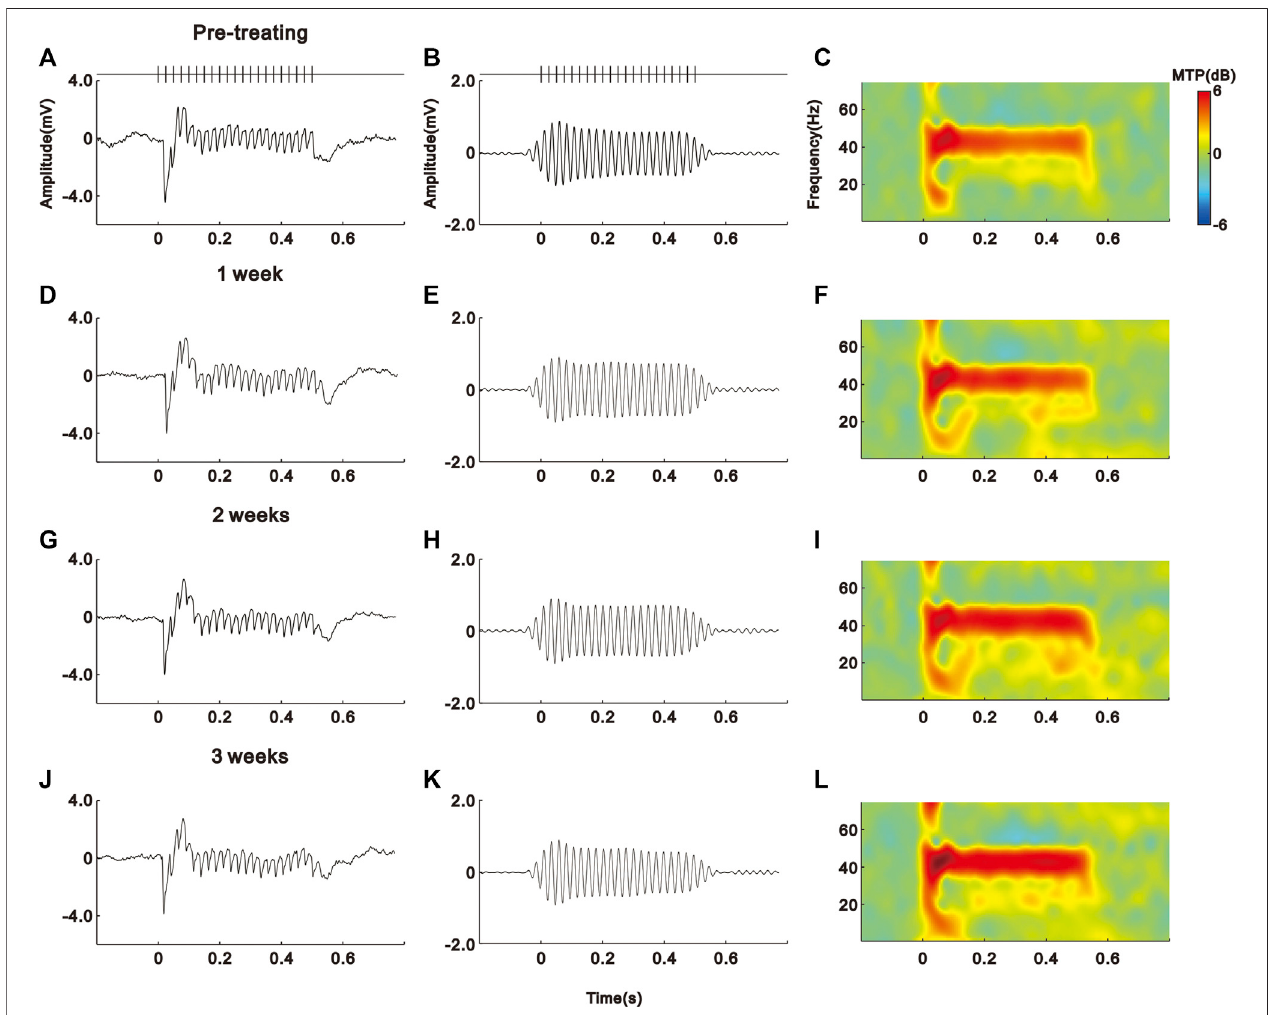
FIGURE 2 | No effect of saline treatment on the ASSR of one example mouse. (A) – (D) Un fi ltered ASSR averaged from 120 trials of EEG signals evoked by 40-Hz clickstimulilastingfrom0to0.5 s.Barsatthetoprepresentthesoundwaveofclick-trainstimulus. (E) – (H) ThesameEEGresponses fi lteredwithabandpass fi lter. (I) – (L) Spectral-temporal spectrum of the fi ltered EEG